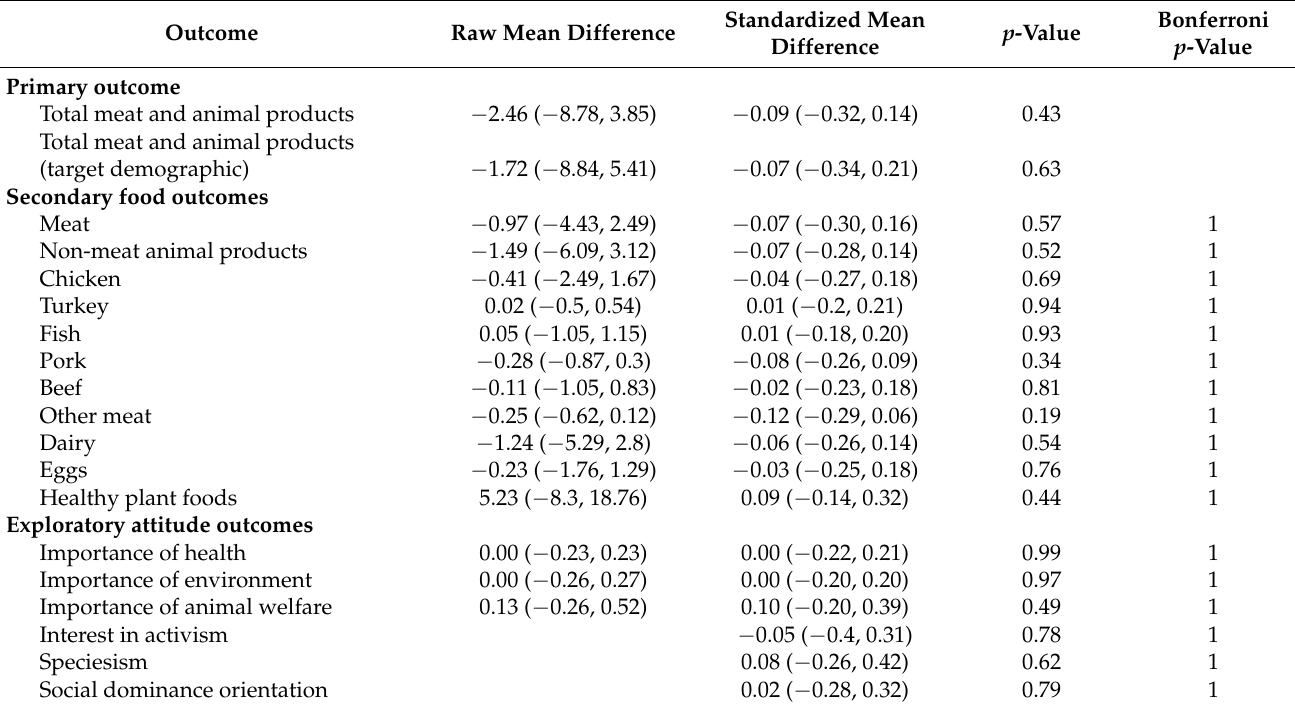
Table 5. For Study 2, estimated intervention effects for the primary outcomes, secondary food outcomes, and exploratory attitude outcomes. Negative estimates represent intervention effects in the desired direction (reduced consumption). “Target demographic”: Participants who reported being Democrats and having graduated 2-year college. Raw mean differences represent ounces consumed over the past week for the primary outcome and secondary food outcomes; they represent units on a 7-point Likert scale for the perceived importance items; and they are omitted for the three composite scales, which were already standardized. Brackets are 95% confidence intervals without correction for multiple testing.